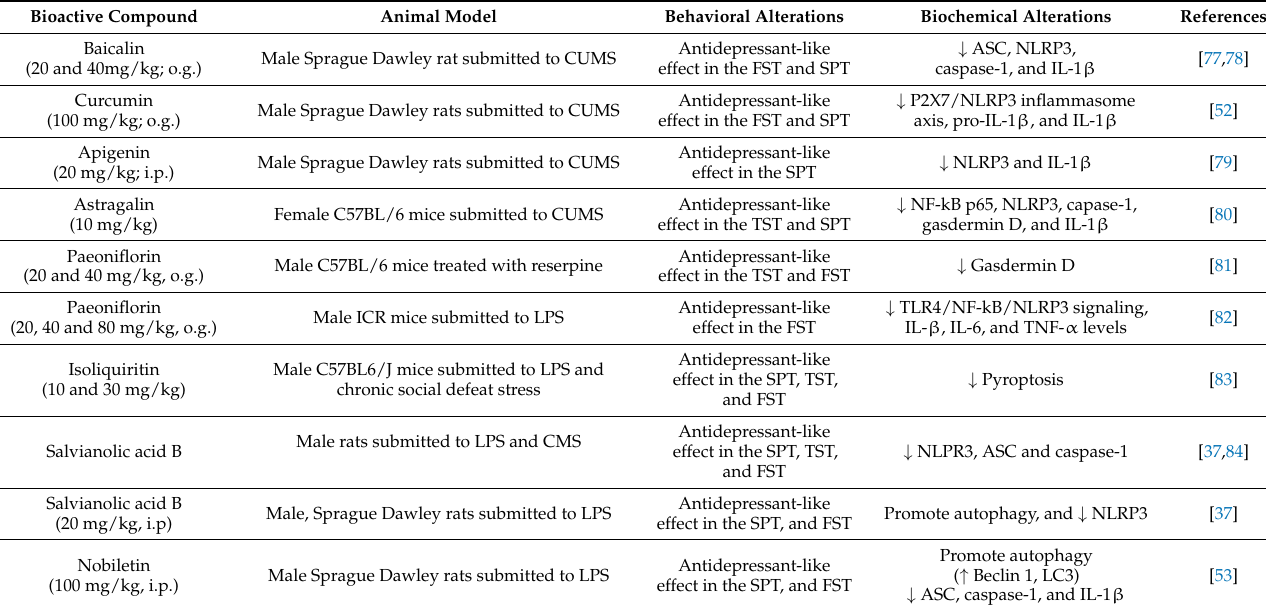
Table 1. Antidepressant and anti-inflammatory effects of bioactive